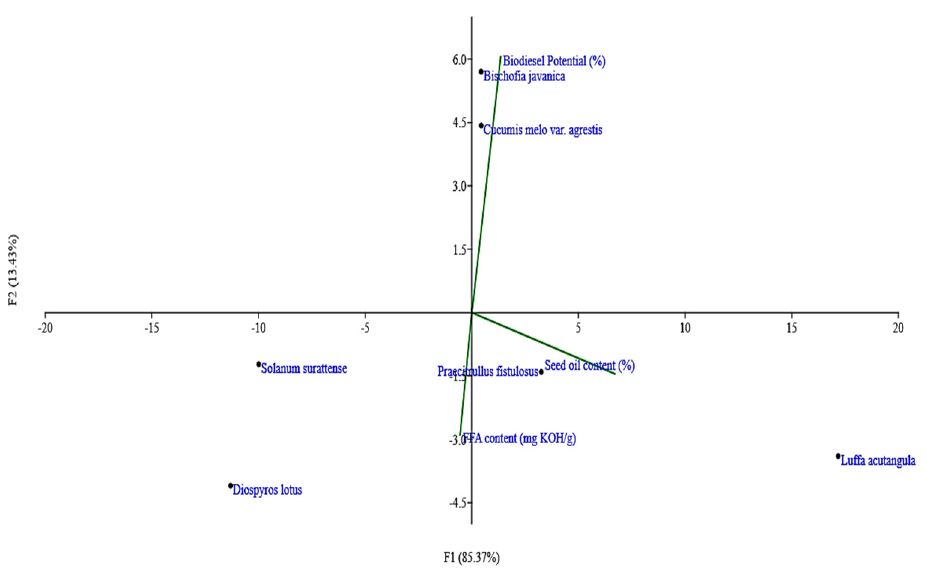
Figure 8. PCA biplot of matric variables of novel non-edible biomass resources (bioenergy crops) Variance proportions: axis 1, 85.37%; axis 2, 13.43%; and axis 3, 1.19% (not shown).